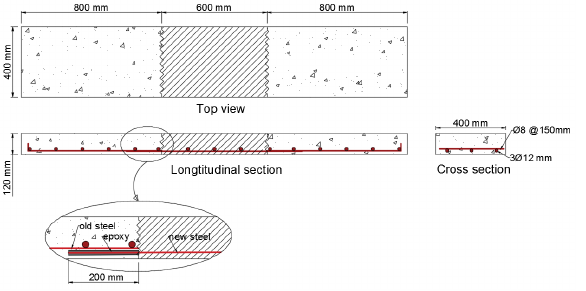
Figure 5: Dimensions and details of specimens ROWS5.